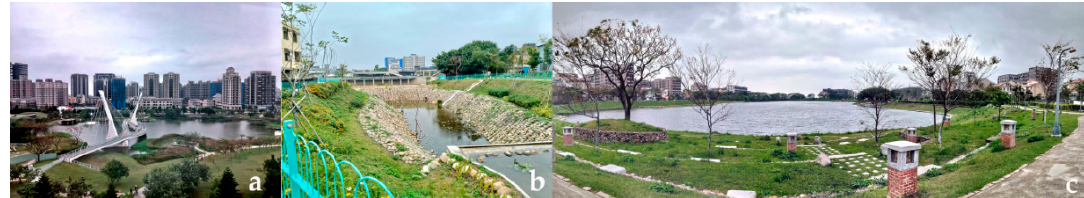
Figure 1. Various installations and facilities around ( a ) Blue Pond Park, ( b ) Chung Yuan Eco Pond Park, and ( c ) Hengshan Calligraphy Park.